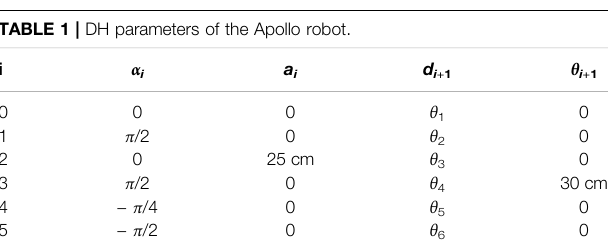
TABLE 1 | DH parameters of the Apollo robot.